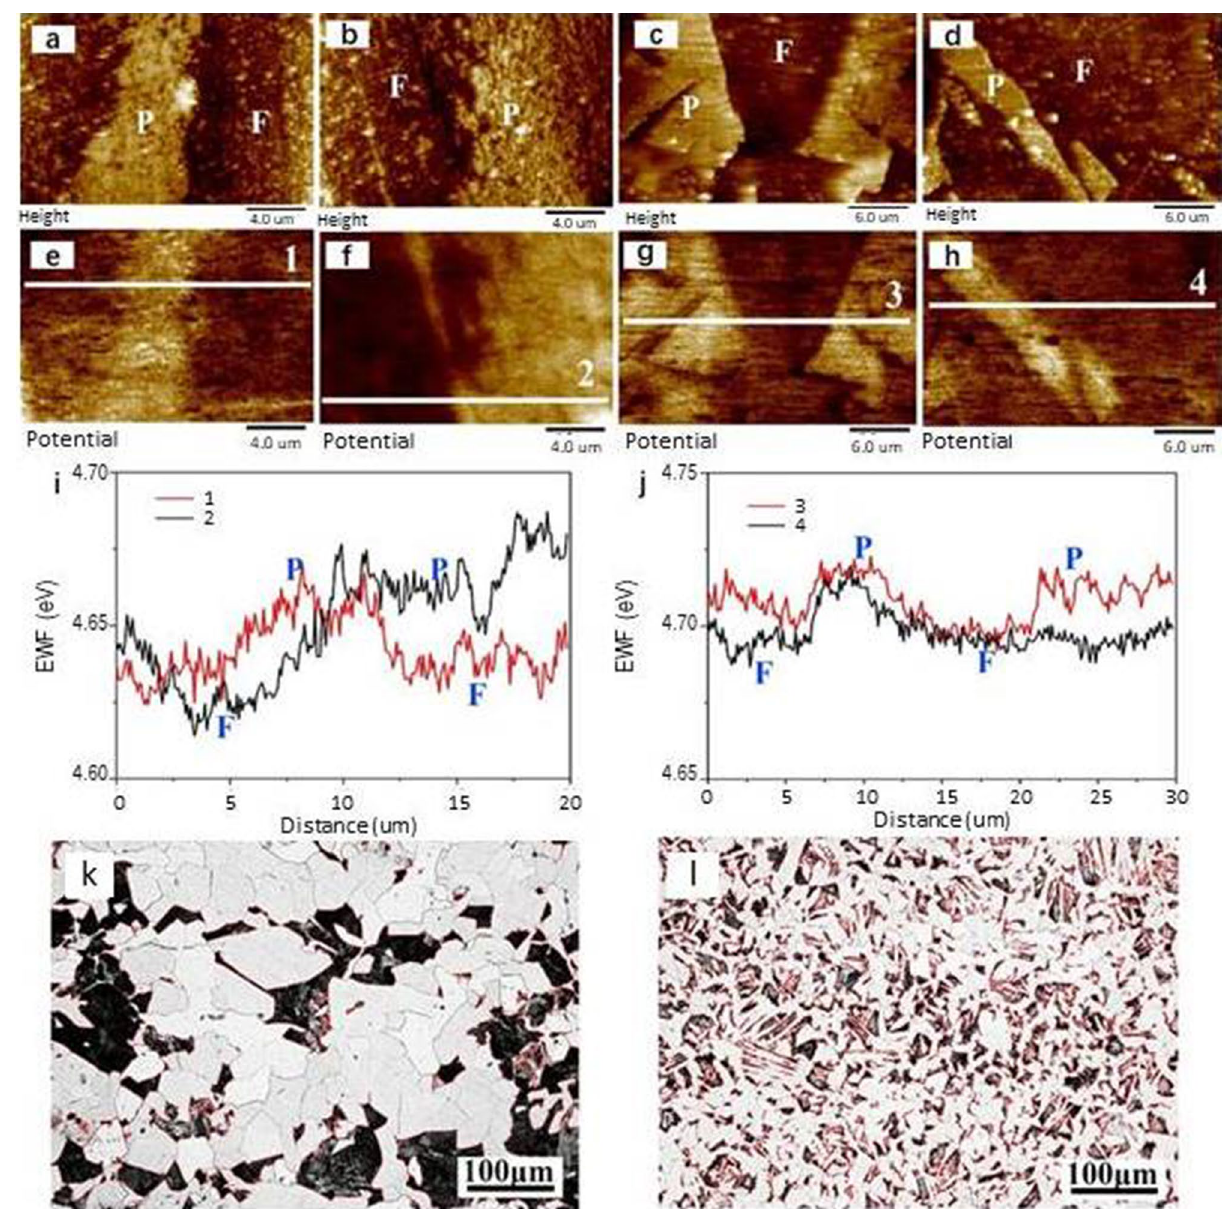
Figure 6. (a-d) Topographical maps of LCF ( a , b ) and LCA ( c , d ), P represents pearlite and F represents ferrite in the images; ( e – h ) corresponding potential maps of LCF ( e , f ) and LCA ( g , h ); ( i ) line profile of potential change [along lines 1 and 2 in ( e ) and ( f ) respectively] in LCF, ( j ) line profile of potential change [along lines 3 and 4 in ( g ) and ( h ), respectively] in LCA; ( k ) optical micrographs of LCF with red interfacial lines; ( l ) optical micrographs of LCA with red interfacial lines.